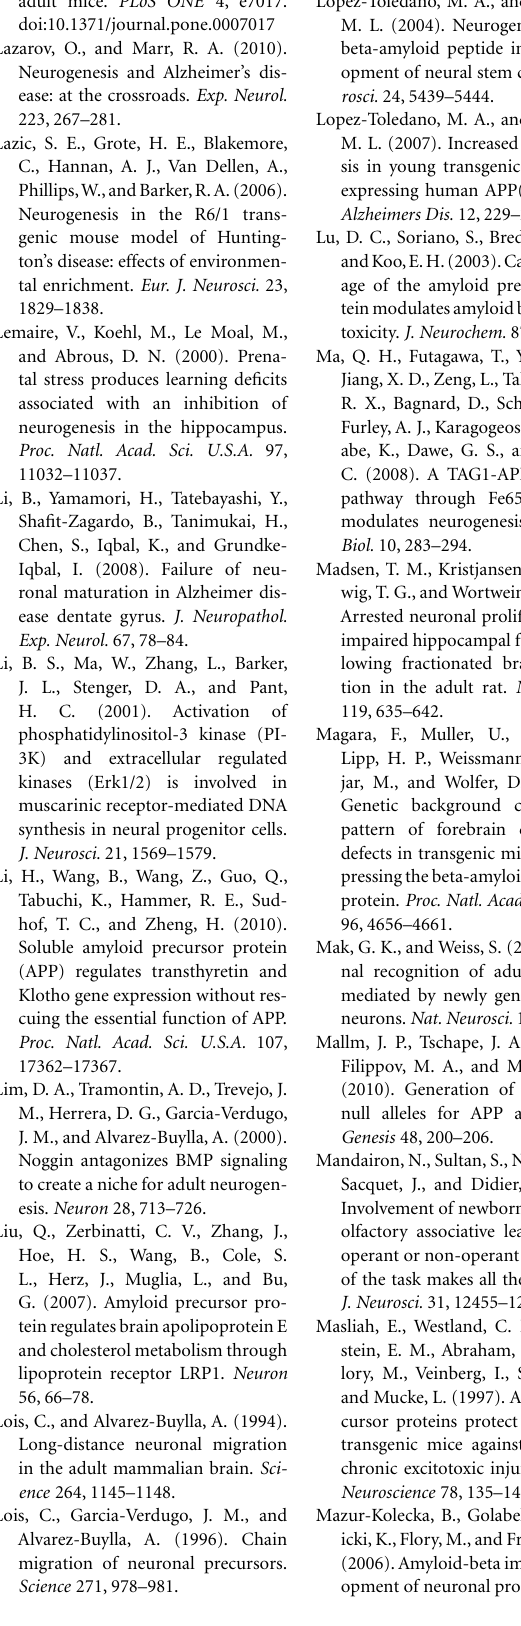
Klotho gene expression without res- cuing the essential function of